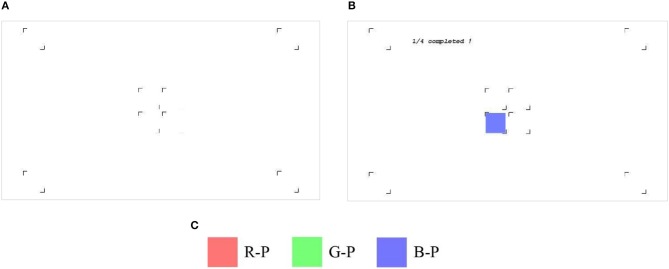
The layout of the experiment. (A) The original pattern; (B) the screenshot of the “blue” experiment; (C) the legend of the three stimuli.